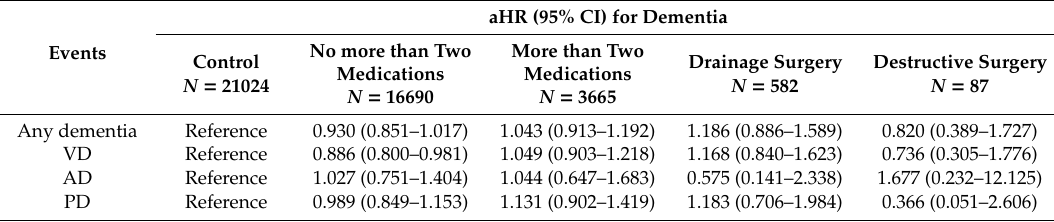
Table 4. Correlation between glaucoma severities and the development of dementia